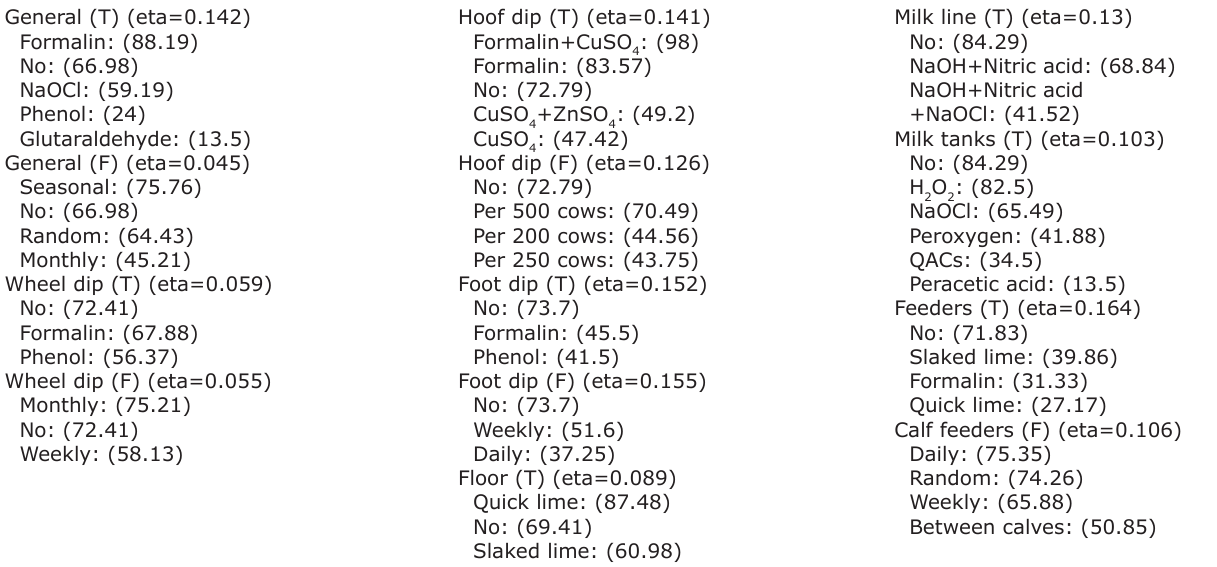
Table-4: Impact of disinfection and disinfectants on microbial profile count, eta-squared measures of association of each disinfection type and frequency, and mean ranks in descending order of each disinfectant type (T) and frequency (F). General (T) (eta=0.142) Formalin: (88.19) No: (66.98) NaOCl: (59.19)